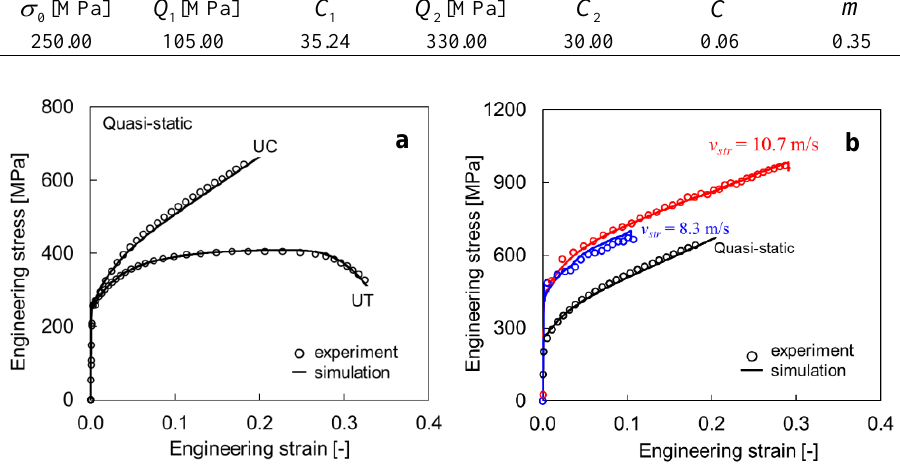
Figure 2. (a) Quasi-static engineering stress-strain compression and tension curves compared to the numerical predictions. (b) Uniaxial compression tests against the numerical mechanical response for several loading